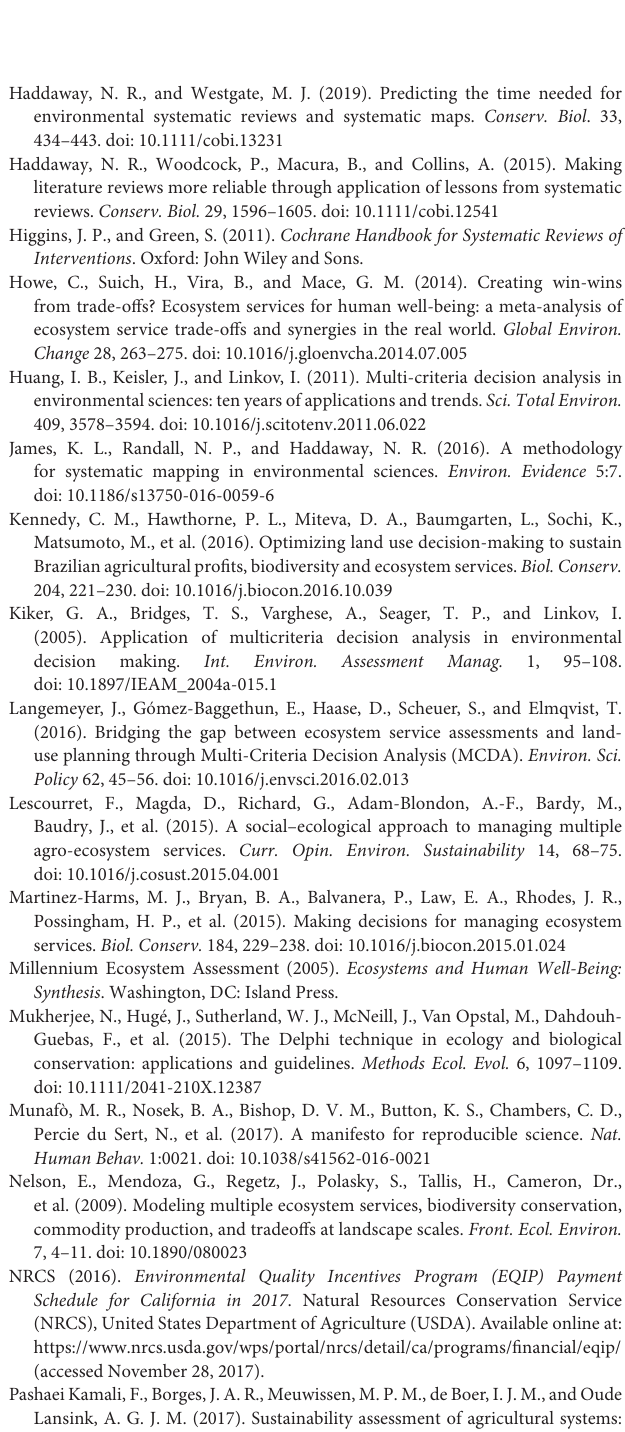
Table S1 | The costs of management practices. Table S2 | Weights set by the TNC staff to create different scenarios when testing the web app. Table S3 | Results from TNC staff when testing the web app using different